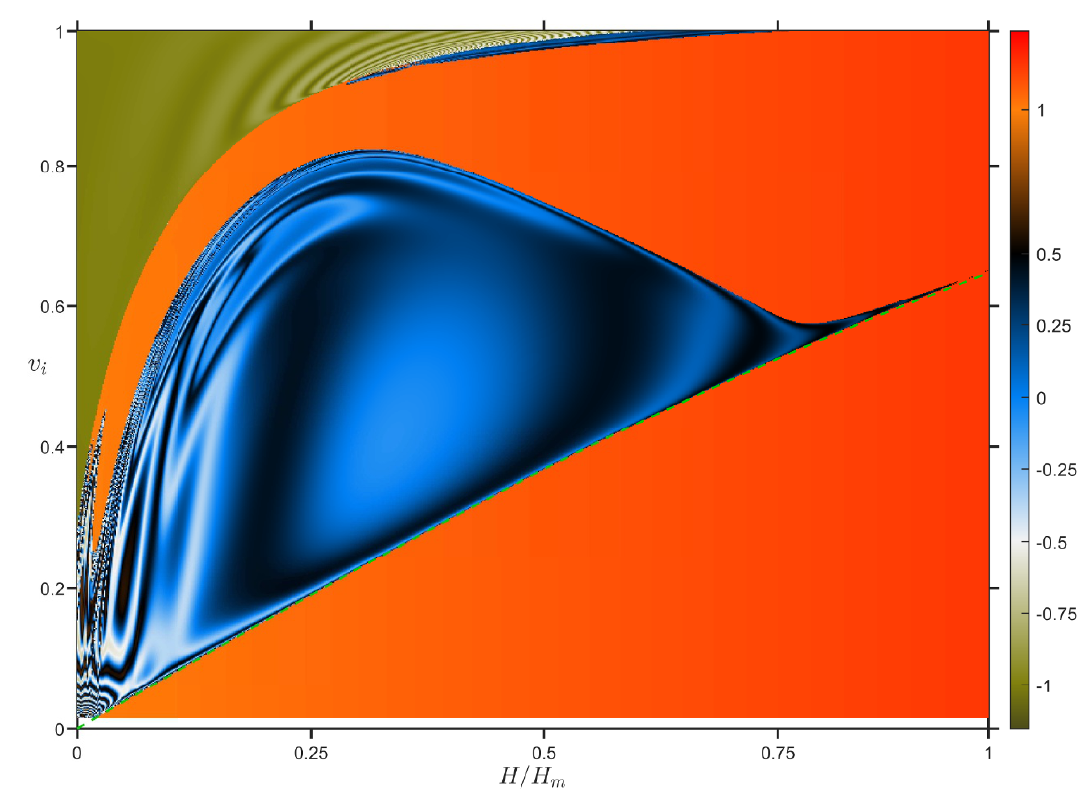
Figure 21 . Φ 1+ ( x ) kink scattering with ˜ φ 3 boundary for H > 0: final state of the scalar field φ (0 , t f ), with t f = | a | + 100. The green traced line is given by the eq. v i